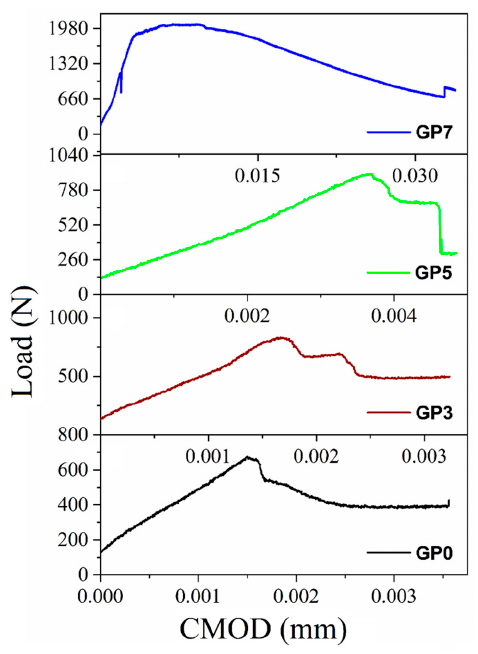
Figure 4. Load-crack mouth opening displacement (CMOD) graphs of geopolymer specimens.